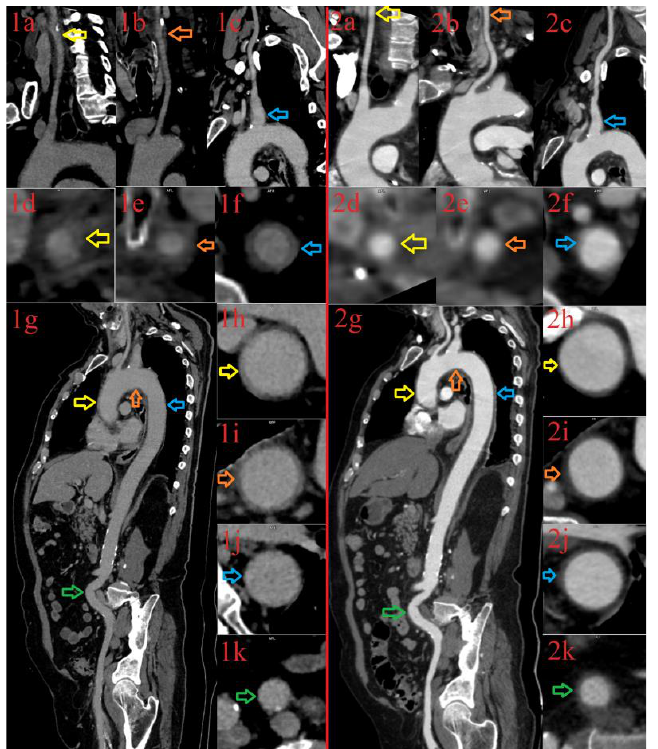
Figure 1. CT aortography of a 69-year-old male with large-vessel vasculitis performed at baseline (Images ( 1a – 1k )) and at the six months follow-up examination (Images ( 2a – 2k )). The baseline CT depicts wall thickening of the aortic arch branches that is barely seen after six months in the right carotid artery (Baseline: Image ( 1a , 1d ); Follow-up: Image ( 2a , 2d ); yellow arrows), the left carotid artery (Baseline: Image ( 1b , 1e ), Follow-up: Image ( 2b , 2e ); orange arrows), and the left subclavian artery (Baseline:: Image ( 1c , 1f ); Follow-up: Image ( 2c , 2f ); blue arrows). In addition, the baseline CT aortography depicts the inflammation of the ascending aorta (Image ( 1g , 1h ), yellow arrows) and the aortic arch (Image ( 1g , 1i ), orange arrows), which was significantly thinner after six months (The ascending aorta: Image ( 2g , 2h ), yellow arrows; The aortic arch: Image ( 2g , 2i ), orange arrows). On the contrary, the descending thoracic aorta (Image ( 1g , 1j ), blue arrows) and iliac arteries (Image ( 1g , 1k ), green arrows) are intact at baseline CT, and appeared inflamed after six months (The descending thoracic aorta: Image ( 2g , 2j ), blue arrows; Iliac arteries: Image ( 2g , 2k ), green arrows). The patient was given a single dose of intravenous immunoglobulin (0.5 g/kg of BW), and azathioprine was introduced (2 mg/kg of BW). The treatment was continued with a low dose of prednisone and azathioprine, leading to a complete laboratory improvement in the inflammatory markers and IgG concentrations during the last follow-up in September 2022. Additional testing included the typing of HLA class I and class II, revealing the presence of HLA A*2 and A*24, B*51 and B*57, DRB1*15 and DRB1*16, and DQB1*05 and DQB1*06 allelic